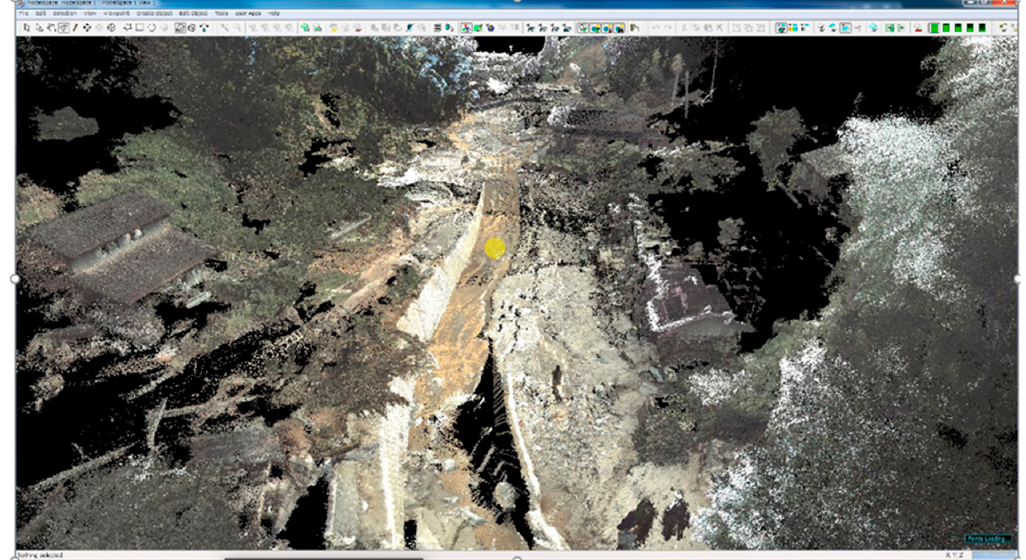
Figure 10. Bird’s-eye view of the 3-dimensional image created from PB laser point cloud.